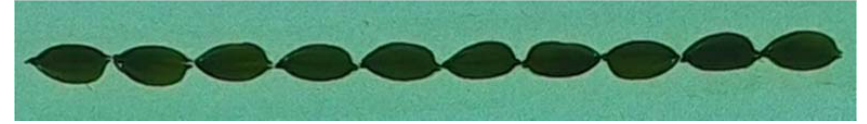
Figure 5. Image of rice grains without overlap.